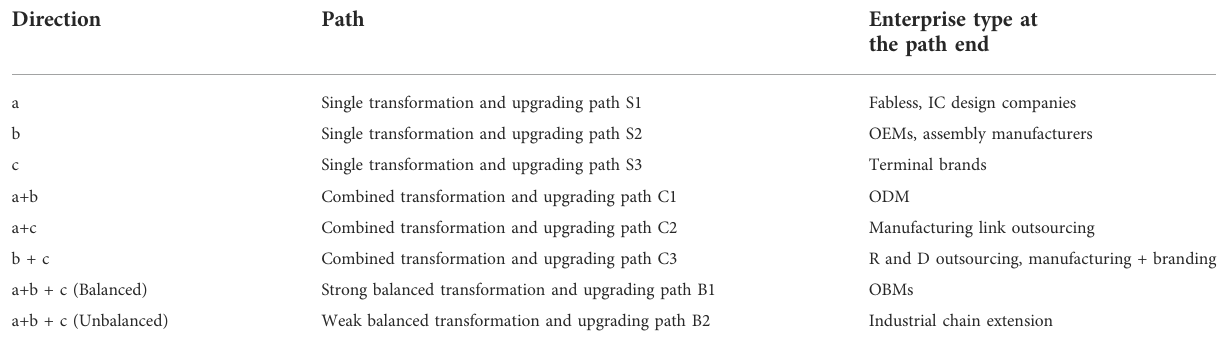
TABLE 3 General transformation and upgrading paths for manufacturing enterprises.